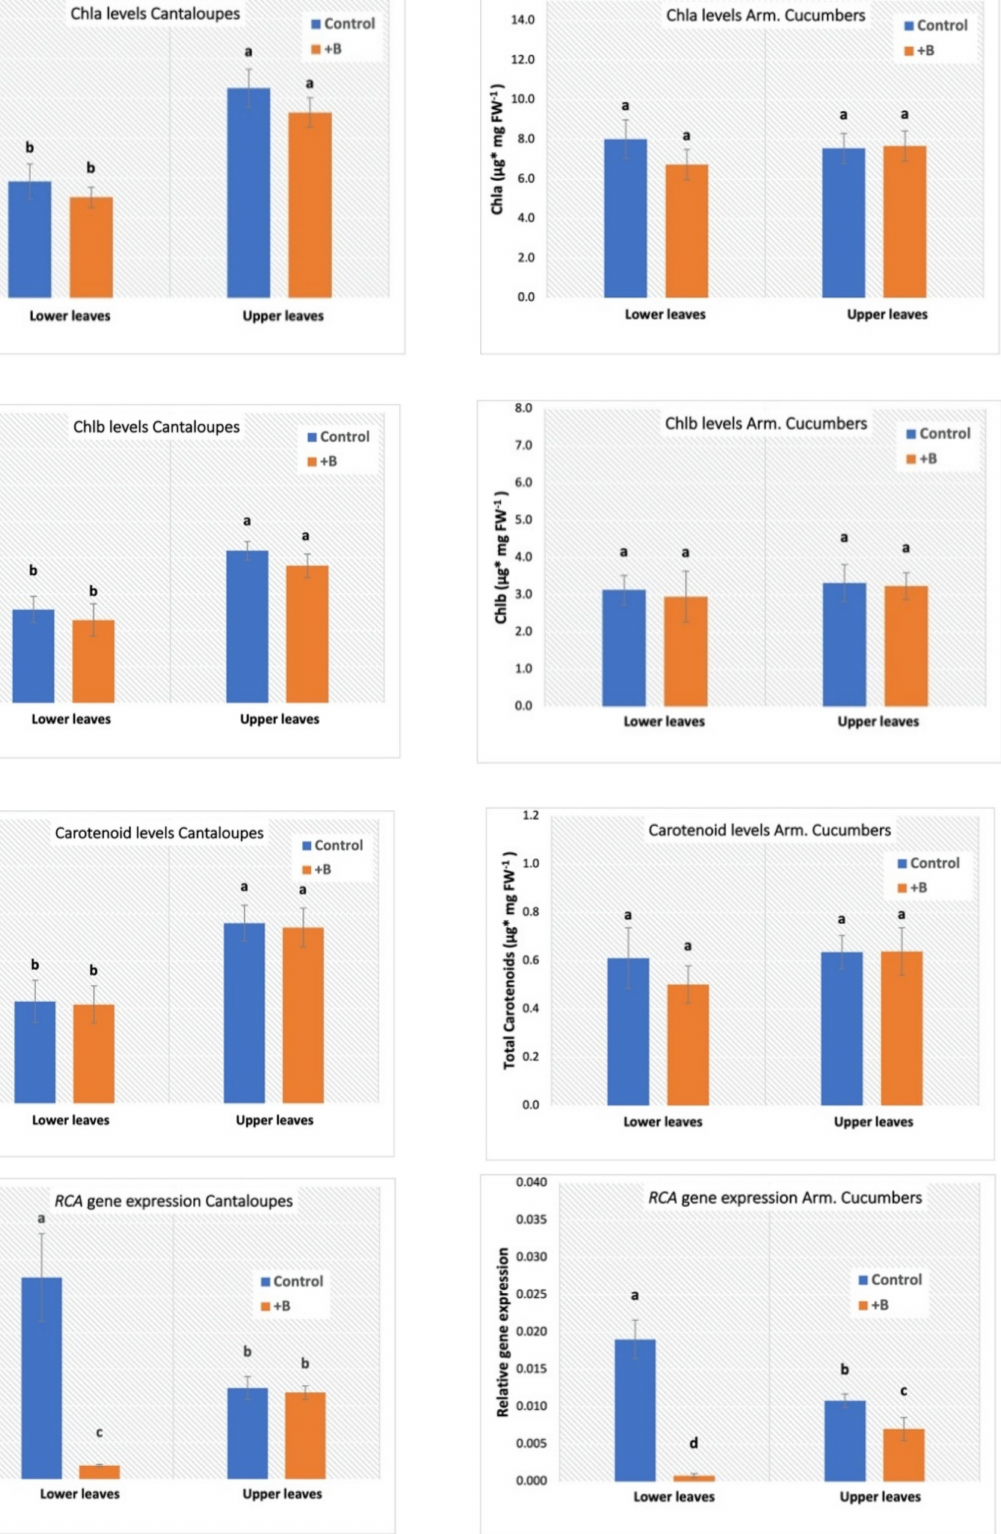
Figure 2. Effect of the oversupply of B (by using H 3 BO 3 ) on the photosynthetic pigment (chlorophyll, carotenoids) content and on RCA1 gene expression of young (close to the apical meristem) and mature (close to the root-to-shoot intersection) leaves of cantaloupes ( C. melo var. Cantalupensis cv. Retato Degli Ortolani) and Armenian cucumbers ( C. melo var. flexuosus cv. Abruzzese Tortarello). Growth period lasted 35 d, where no visible B toxicity symptoms were apparent (Figure 1). Means followed by different letters indicate significant differences ( p = 0.05). Values are the mean of ten replications ( ±